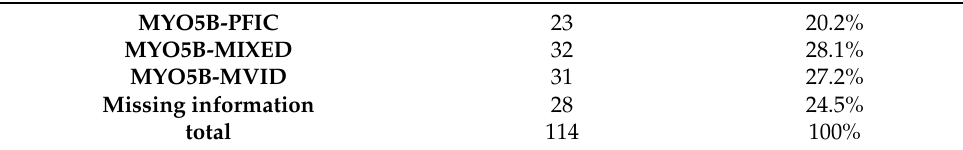
Figure 1. Flowchart scheme illustrating study cohort composition and selection. Table 1. Baseline phenotype characteristics and outcome of 107 patients with biallelic and 7 patients with mono-allelic Myosin Vb (MYO5B)